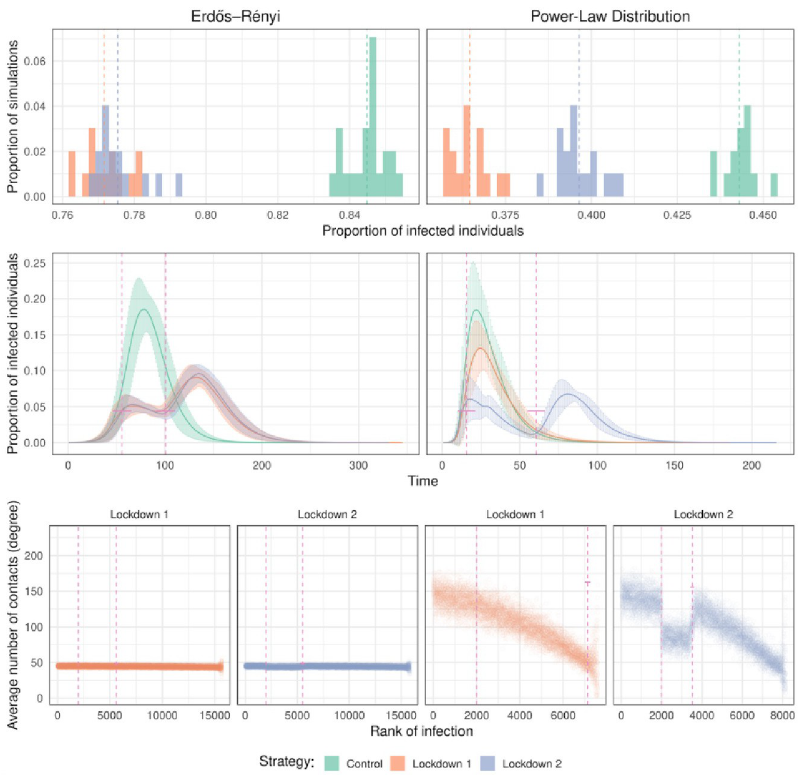
Fig 2. Effect of the different lockdown strategies. The lockdown starts when 10% of the population is infected and lasts for 45 days. Top panels represent the proportion of infected individuals at the end of the infection in 30 different simulations. The panels in the middle represent the number of infected people as a function of time. The color shadings indicate standard deviation or dispersion (computed from 30 repetitions). Vertical bars indicate the start and the end of the lockdown. In the bottom panels, we show the average degree of the infected individuals as a function of their rank of infection for the two lockdown strategies. The controls are shown in Fig 1.